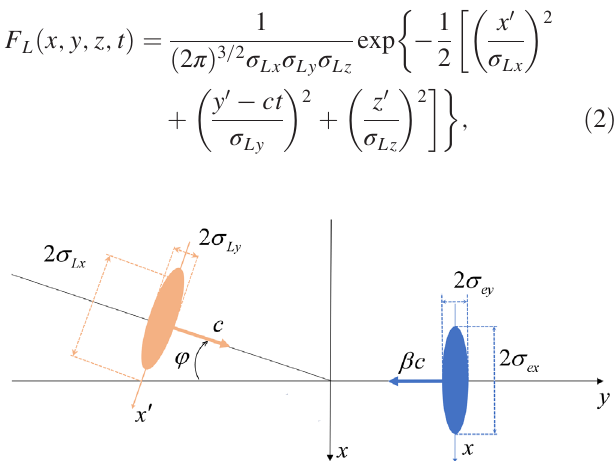
FIG. 3. The layout of the process of inverse Compton scatter- ing; both photon (left, orange) and electron beams (right, blue) have tilted